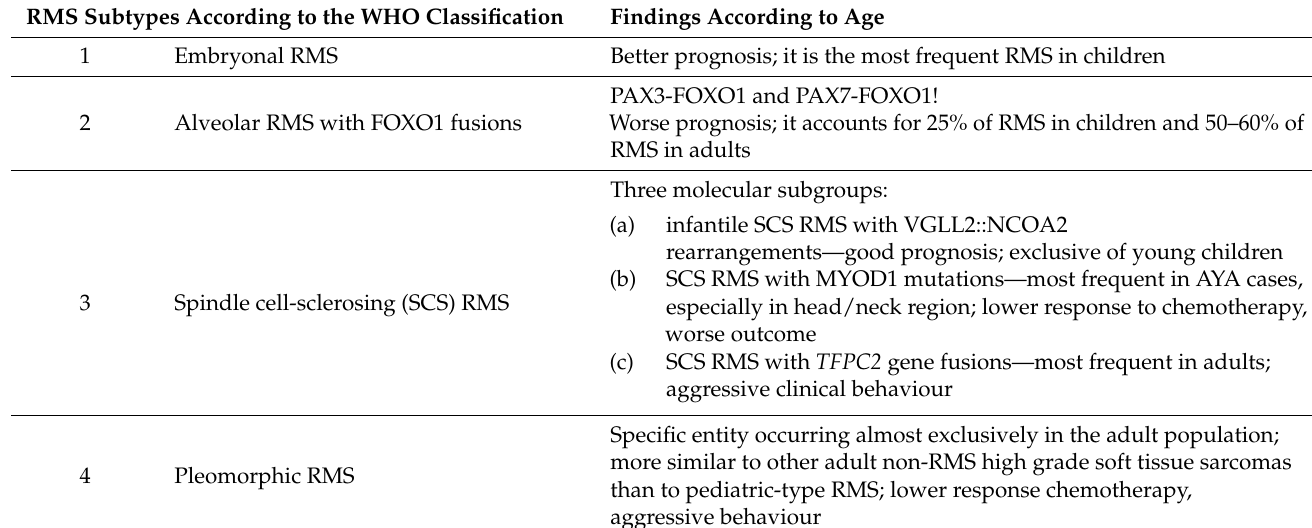
Table 3. Rhabdomyosarcoma (RMS) subtypes according to